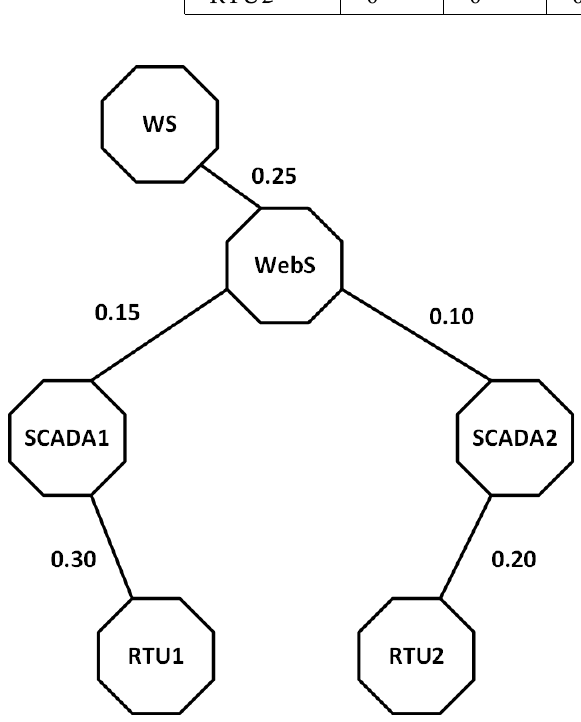
Figure 4. The weighted graph calculated in Eq. 6. The details are shown in Table 3 for di ff erent values of δ